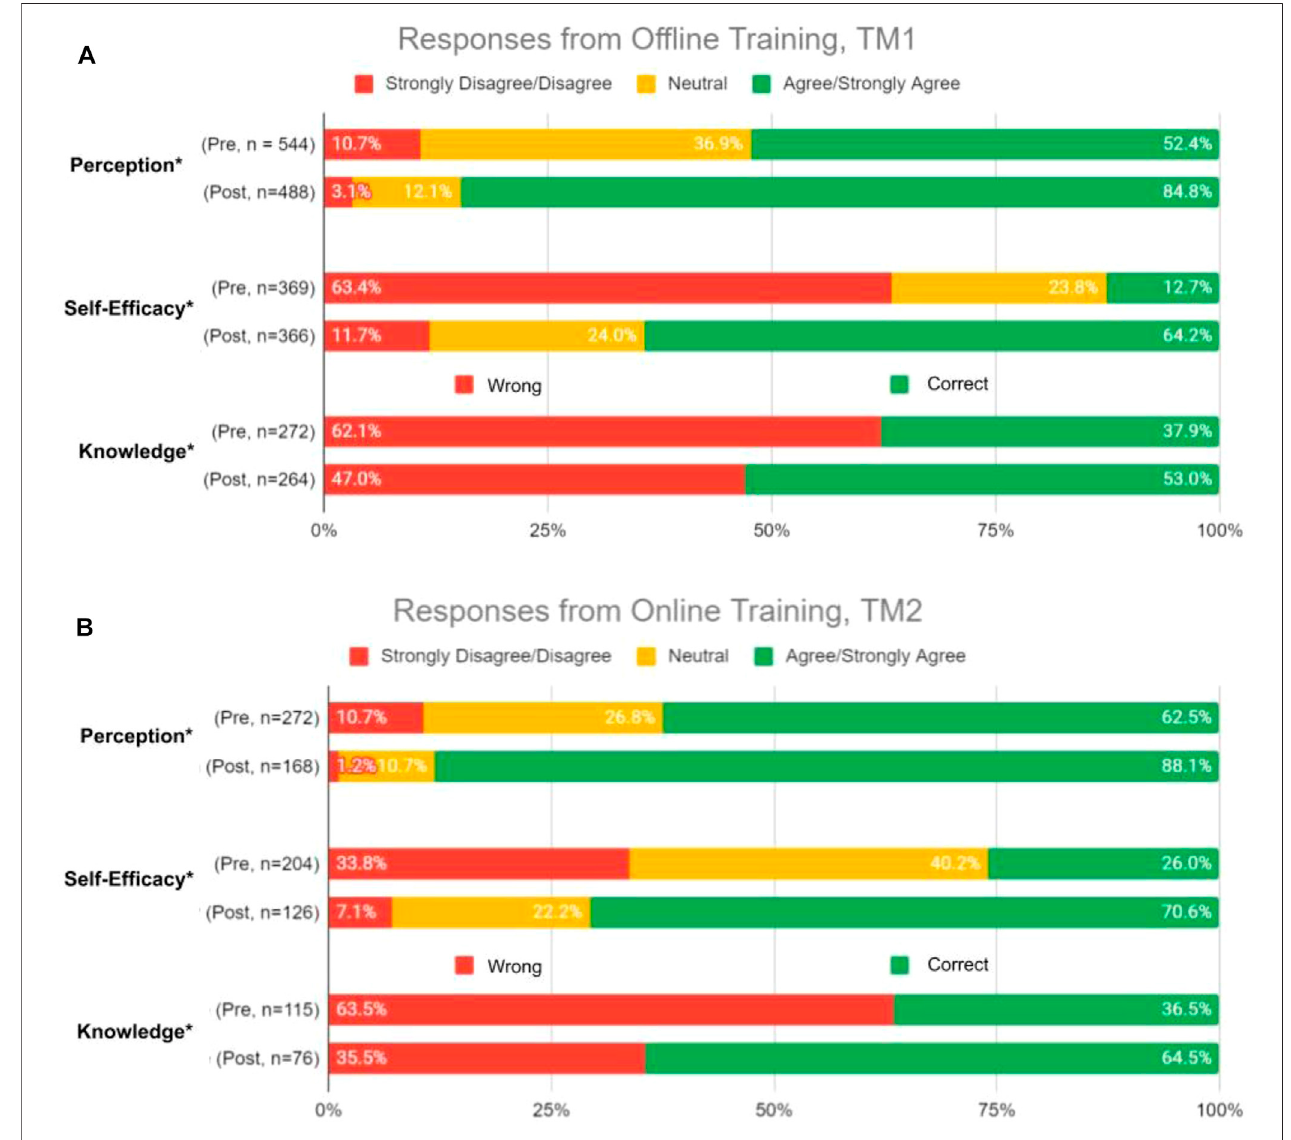
FIGURE7| Overall percent ofrespondents relative to5-pointLikert-typescale labels pre- and post-PGxtraining conducted (A) Of fl ine,TM1; and (B) Online, TM2. Survey domains included Perceptions of the relevance and clinical utility of PGx, Self-Ef fi cacy through perceived ability to use PGx information in guiding medical decisionsandengageinpatientdiscussionsaboutPGxtesting,andKnowledgequestionsonthePGx-basedcasestudies.Samplesize,n,displayedthetotalnumberof responses received per domain during surveys pre- and post-training. *Statistically signi fi cant p-values ( p < 0.05) were observed in changes from pre- and post- training responses.